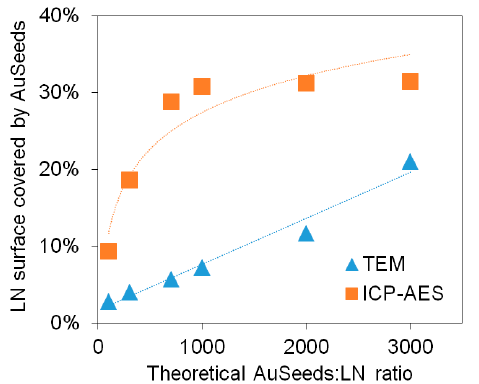
Figure 3. Percentage of the LN@BPEI surface covered by AuSeeds for each LN@BPEI@AuSeeds sample as determined by TEM imaging and ICP-AES analysis.